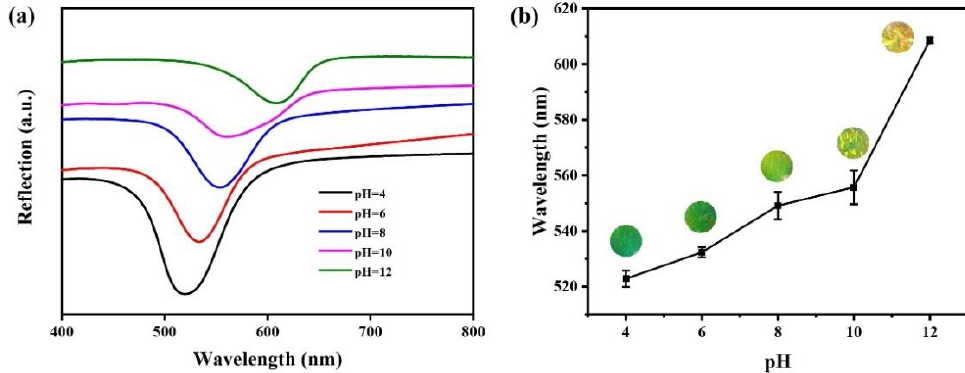
Figure 7. ( a ) UV-visible reflection spectra of CLC-PAA PC films at different pH; ( b ) The wavelengths of the reflection light and the optical images of CLC-PAA PC films under different pH.